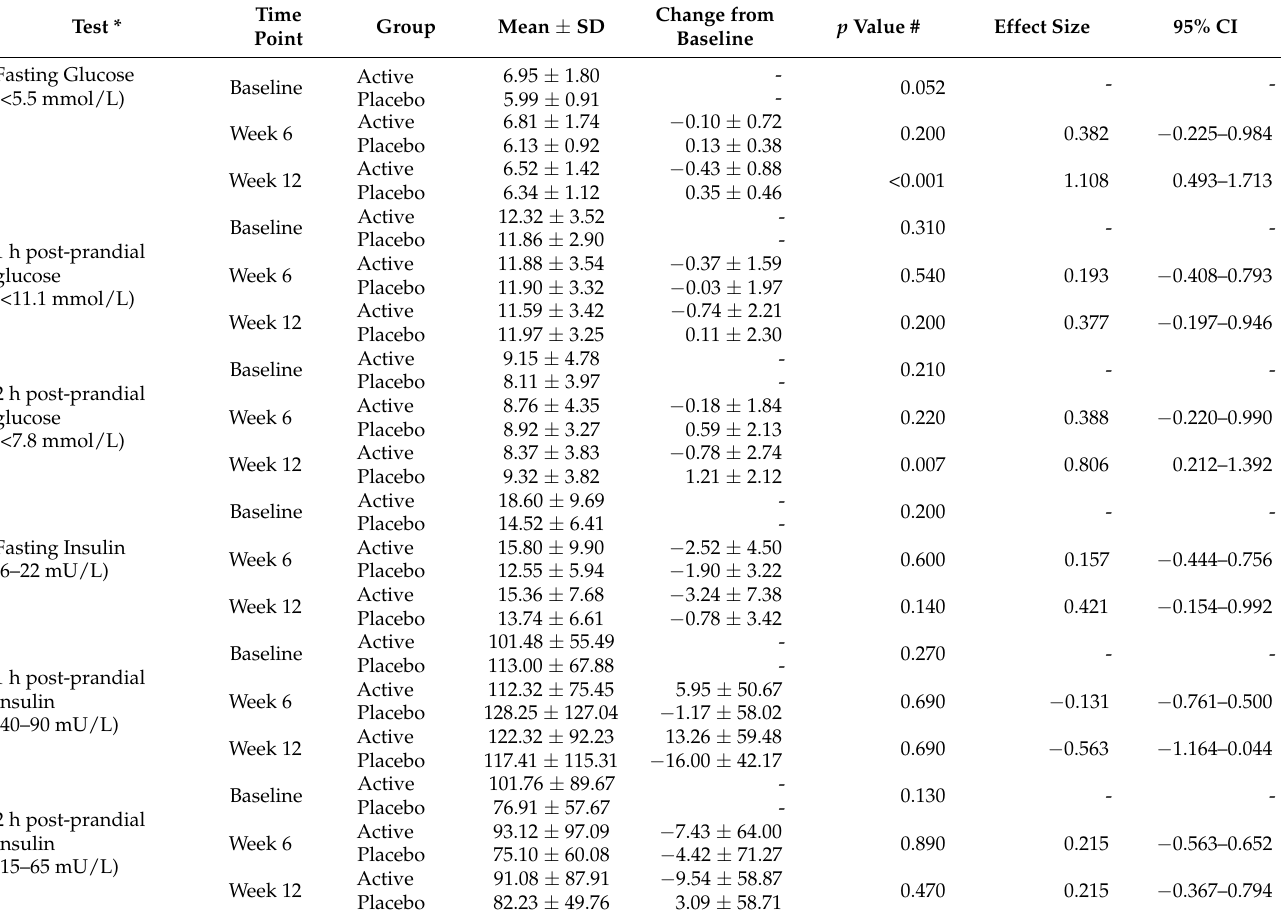
Table 2. Blood glucose and insulin levels for Active treatment and Placebo groups at baseline, week 6 and week